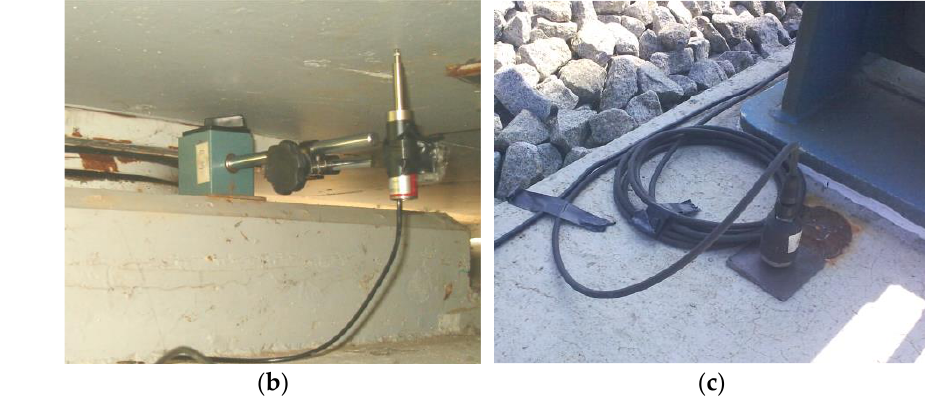
Figure 13. Measurement of displacements and accelerations: ( a ) LVDT on the deck slab; ( b ) LVDT on the support; ( c ) accelerometer on the main girder.